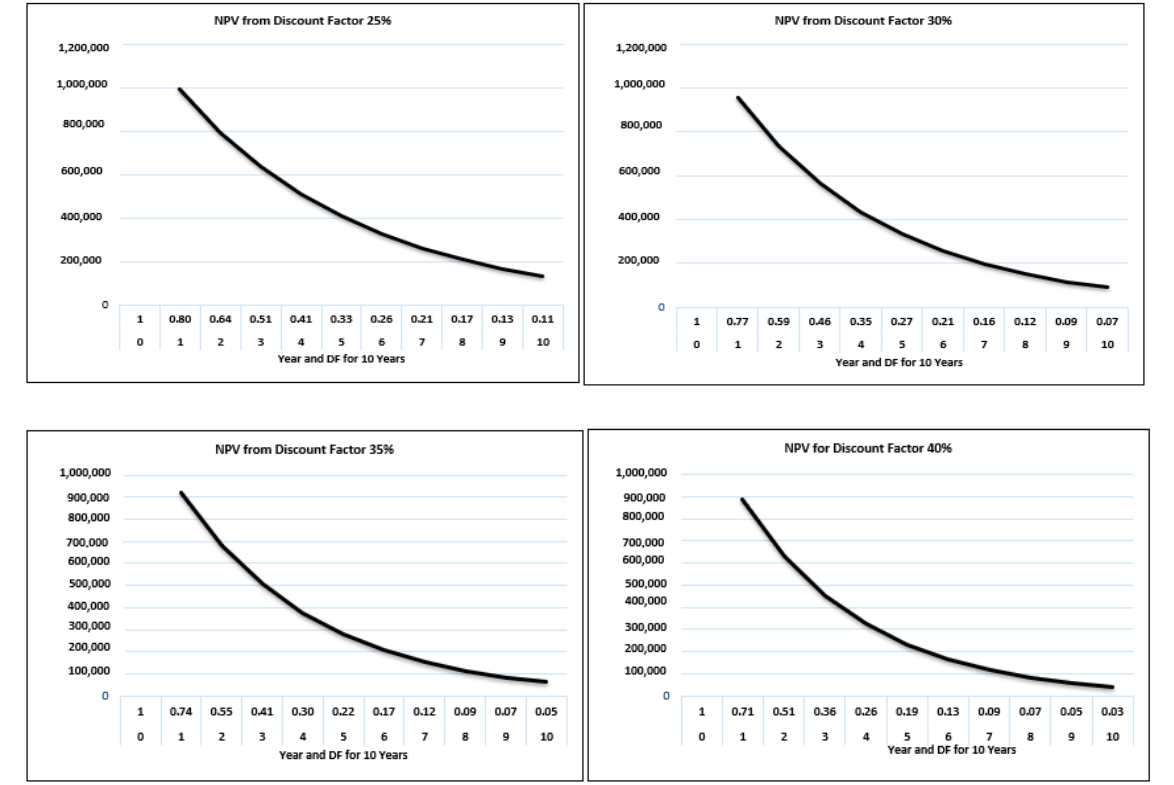
Figure 13. Net Present Value (NPV) for 10 Years Investment with various discount factor.